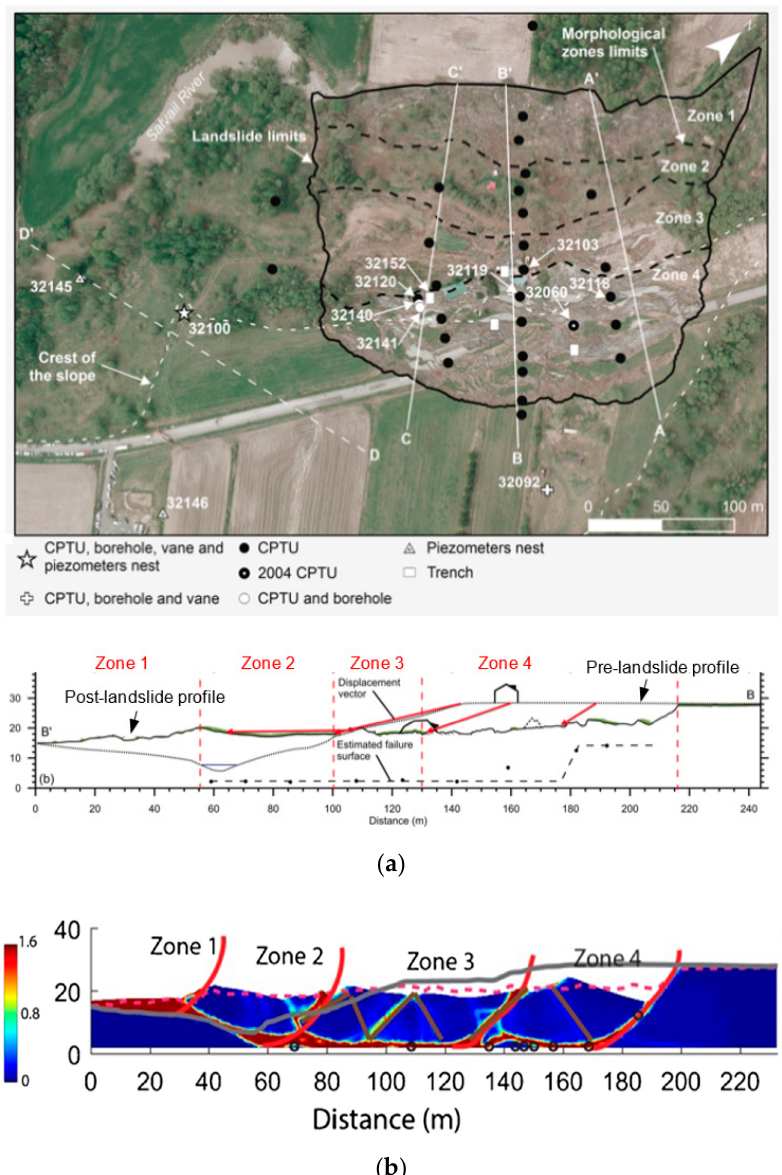
Figure 14. Saint-Jude landslide: ( a ) map and section (Locat et al., 2017); ( b ) Equivalent shear strain field after 87 s (PFEM code; Zhang et al., 2019).